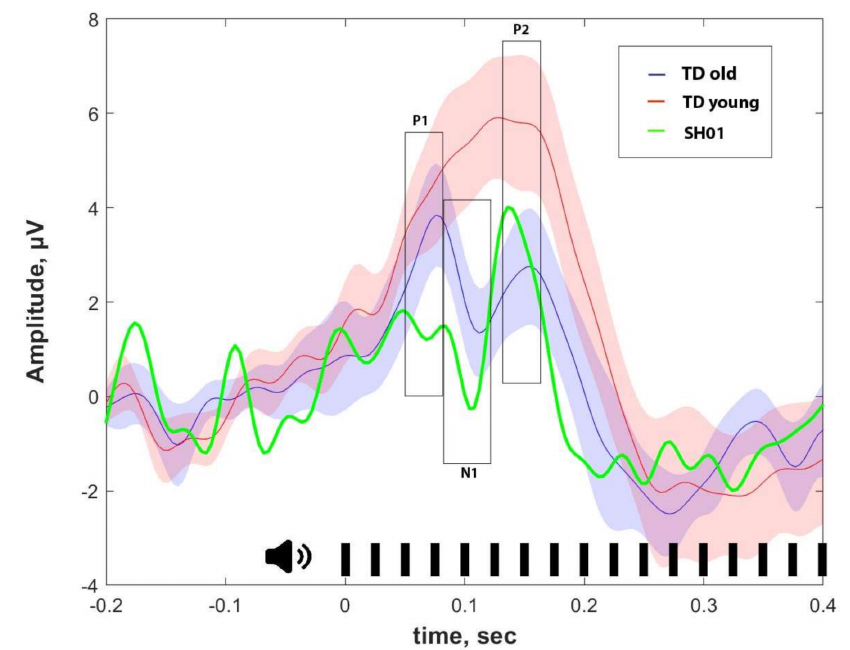
Figure 6. Auditory event-related potentials (ERPs), in Fz electrode with SH01 shown in green, the younger TD group (TD young) is shown in red, and the old, age-matched with SH01 control group (TD old) is shown in blue. Opaque blue and red shading illustrate 95% confidence interval. The time of stimulus presentation is 0. Time windows for P1 (50–80 ms), N1 (80–120 ms), and P2 (130–160 ms) are shown in